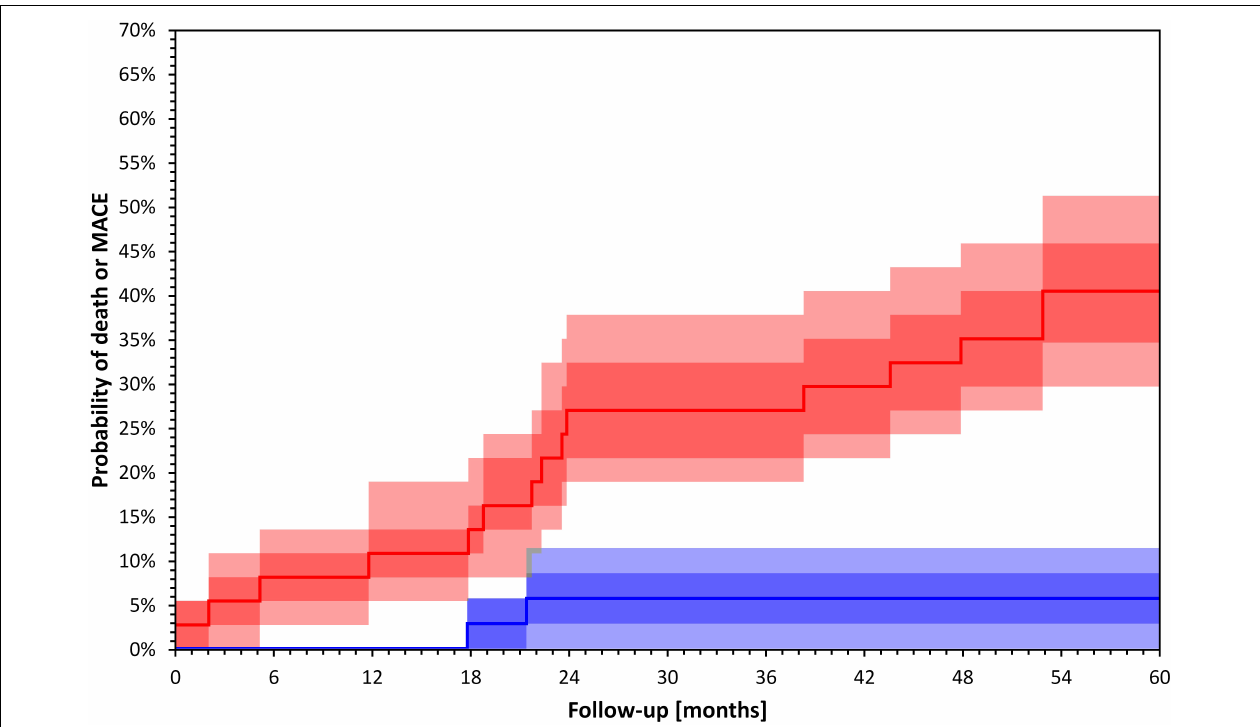
FIGURE 2 | Kaplan–Meier survival curves of total mortality and major cardiac events 72 HD patients included in a recently published study (Poulikakos et al., 2018) stratified by QRS-T angle calculated by TCRT above (red) and below (blue) median value ( p = 0.000 Log Rank test). Darker bands depict interquartile ranges and the lighter bands ranges between 10th and 90th percentiles. The calculation of confidence intervals was performed using bootstrap 10,000 repetitions. Major cardiac events were defined as sudden cardiac death, acute coronary syndrome, coronary revascularization or admission due to heart failure or